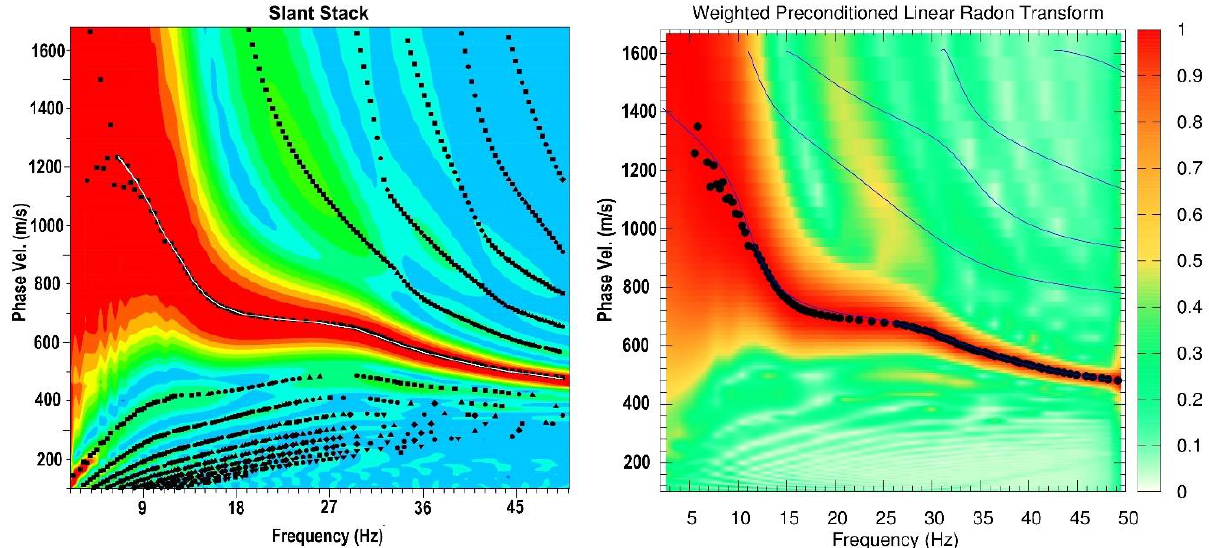
Figure 6. Phase velocities for the model structure in Table 2 computed from seismograms in Figure 5 are shown. The left panel corresponds to the method of slant stacking (white line). In the right panel, the method of linear radon transform weighted and preconditioned is used (solid circles).